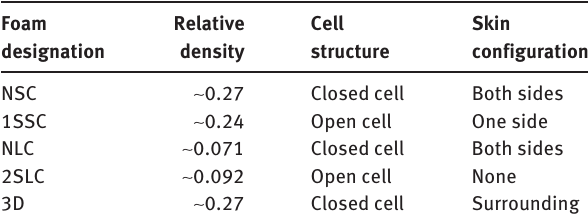
Table 1 Structure comparison of different types of aluminum foam